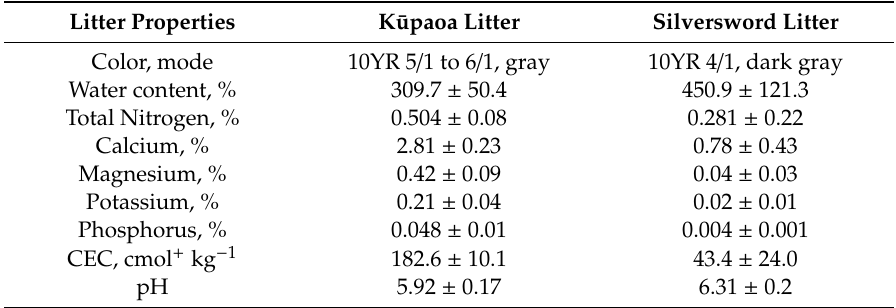
Table 2. Average values ( ± S.D.) for selected physical and chemical properties of k¯upaoa leaf litter collected on litter islands at ~2610–2710 m; sample N: eight. For comparison, the column on the right shows data for litter properties of silverswords at Haleakal¯a, at ~2510 m [35]. Dry-soil color indicates the mode for the sampling set (Munsell Soil Colors [83]). Water content shown is water-retention capacity (WRC, − 33 kPa). Total nitrogen was determined by micro-Kjeldahl method. See text for